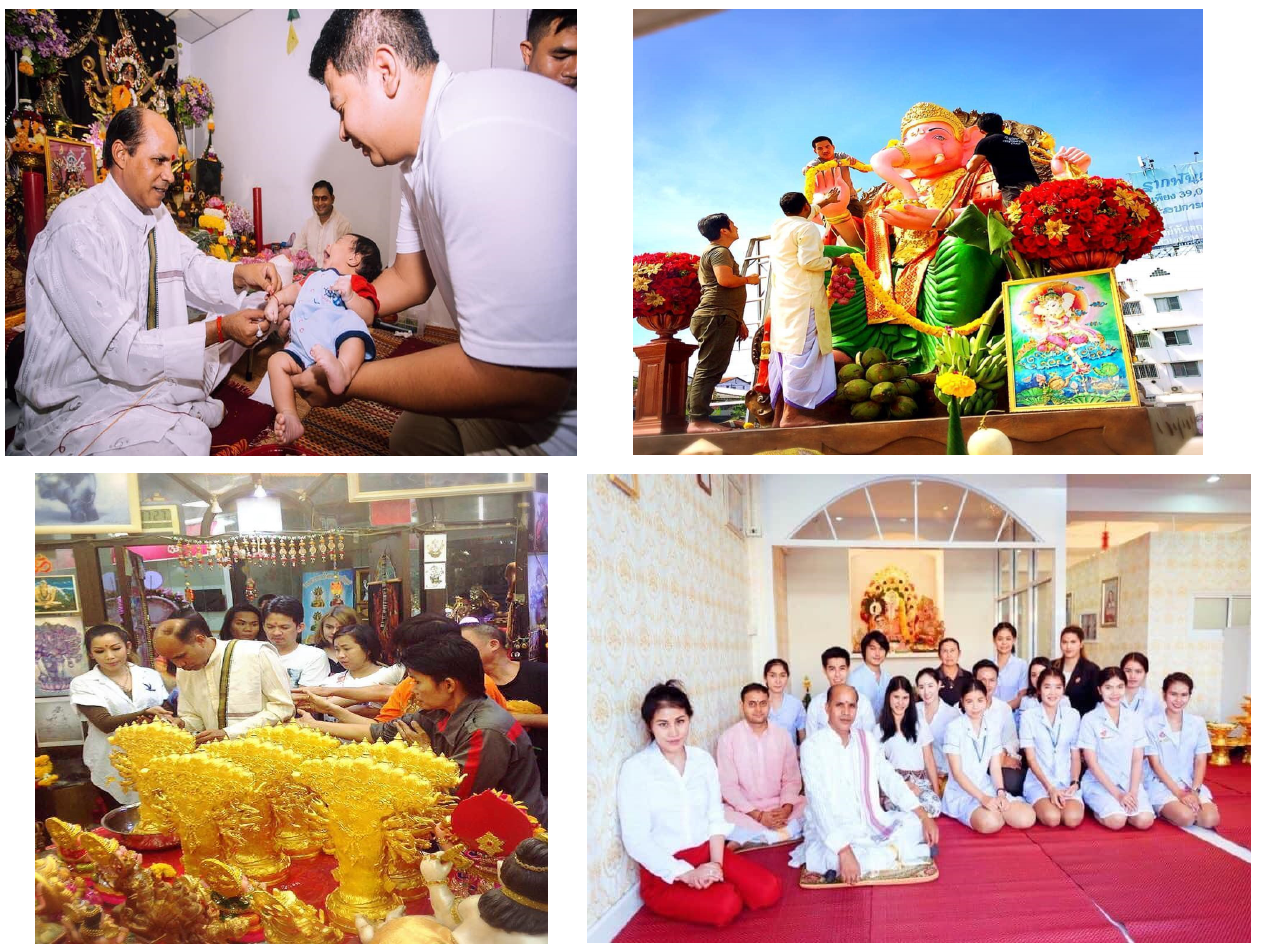
Figure 1. Images show, left–right, top–bottom: Blessing newborn baby, posted on 22 January 2019. Installing a new Ganesa image in Rangsit area, posted on 13 February 2019. Conducting the ceremony for a shop selling religious icons in Imperial Mall in Ladprao area, posted on 15 February 2019. With devotees at a beauty clinic after performing pooja at their clinic in Bangkok, posted on 27 February 2019 (Images used with permission).